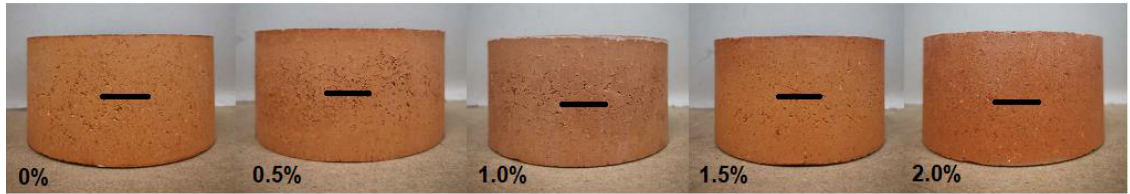
Figure 14. Efflorescence on bricks for mixes with 0%, 0.5%, 1.0%, 1.5%, and 2.0% CBs.